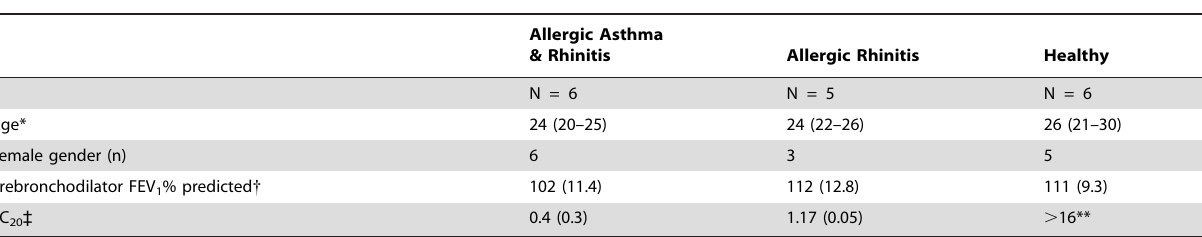
Table 1. Baseline characteristics.